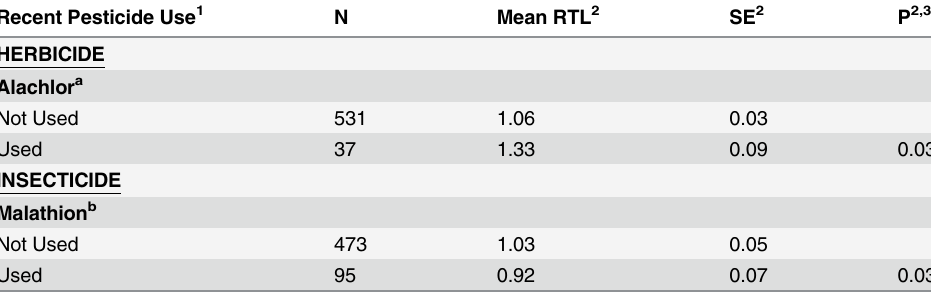
Table 3. Recent pesticide use and mean relative telomere